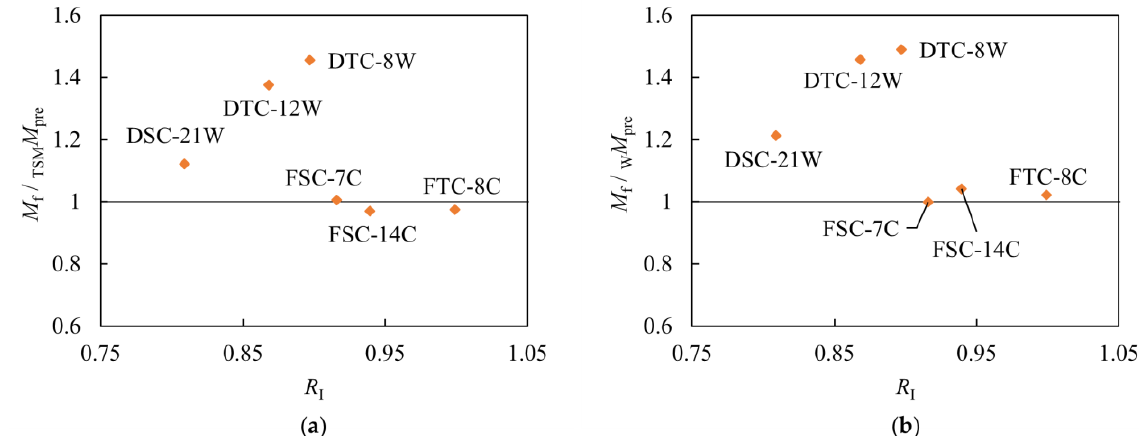
Figure 14. Relationship of the prediction accuracy and R I of ( a ) TSM approach and ( b ) Weibull stress approach.